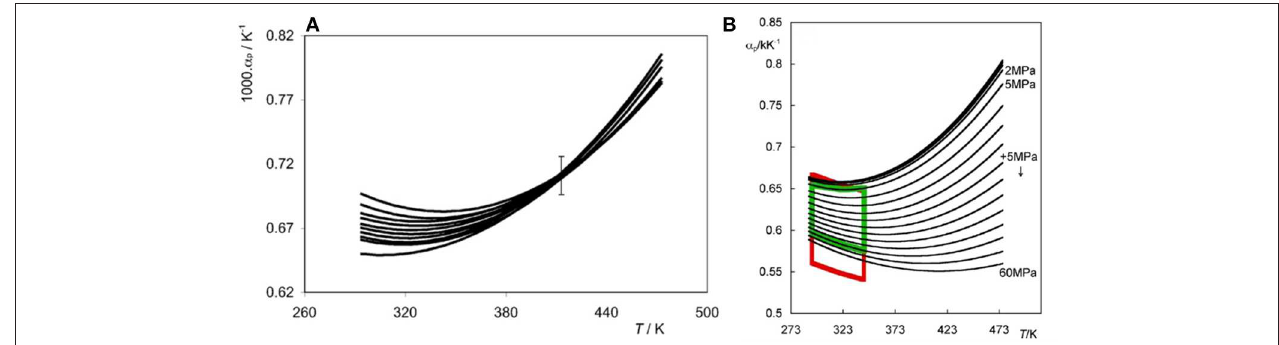
FIGURE 1 | (A) Thermal expansion coefficient, α p as a function of temperature and at atmospheric pressure for each member of the [C n C 1 im][Ntf 2 ] family (C 14 -C 2 from top to bottom). The error bar corresponds to an average uncertainty for all fits. (Reprinted from Tariq et al., 2010 with permission from Elsevier) (B) α p for [C 4 C 1 im][Ntf 2 ] as a function of temperature at different pressures. The top four unlabeled isobars in the right panel correspond to pressures of 0.1, 0.25, 0.5, and 1 MPa. The red lines represent the boundaries of the data presented by Navia et al. (2010a), Navia et al. (2010b) (isotherms between 293 and 353K and isobars between 5 and 50 MPa). The green lines highlight the same boundaries for the set of data measured by Nieto de Castro et al. (2010). (Reprinted from Nieto de Castro et al., 2010 with permission from Elsevier).